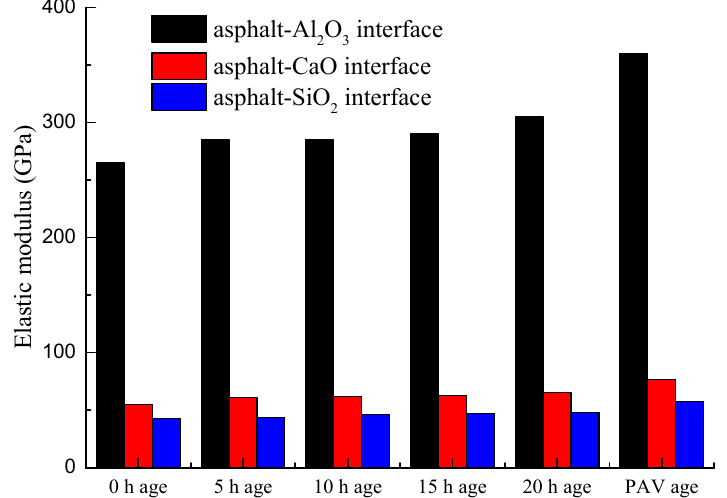
Figure 5. The elastic modulus of asphalt-binder aggregate mineral interface.